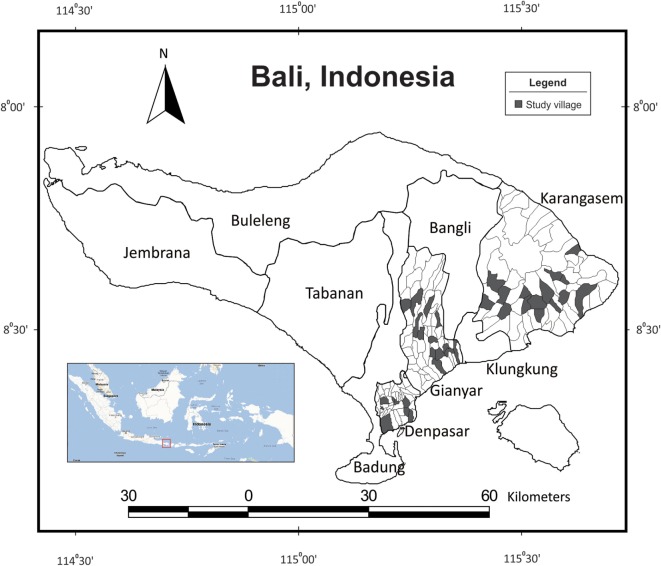
Surveyed villages (n = 37) in Denpasar, Gianyar, and Karangasem regencies on the island of Bali, Indonesia (see inset).